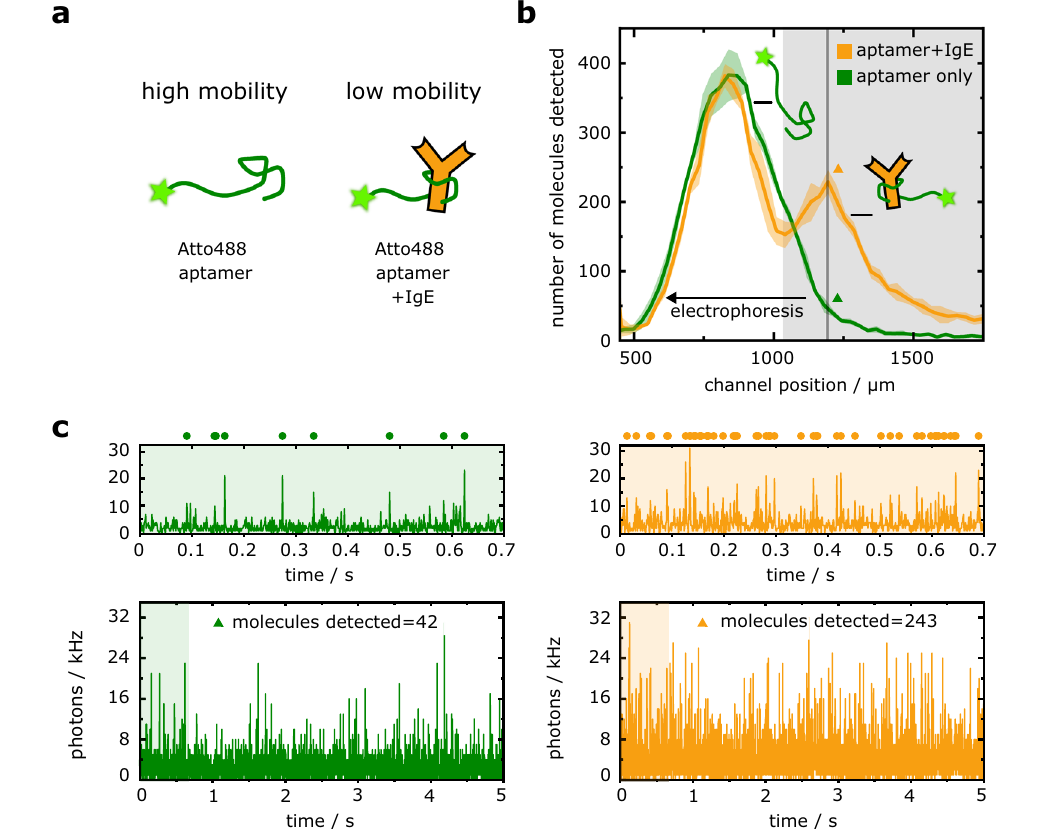
Fig.3|DigitISAimmunosensingofIgEwithanaptamerprobe.a AnIgE-aptamer probeisaddedtoitstargetIgE.Bindingoftheantibodyreducestheelectrophoretic mobility of the probe, allowing for fast electrophoretic separation of the aptamer probe from the immuno-complex for subsequent confocal detection. b Electropherogram as obtained by scanning of the confocal volume across the cross-section of the channel in a stepwise manner for the IgE – aptamer sample (orange line; average of N =3 repeats) and for the free aptamer probe (green line; average of N =3repeats). The shadedbandscorrespond to the standarddeviation. The region shaded in grey was used to quantify the concentration of IgE by